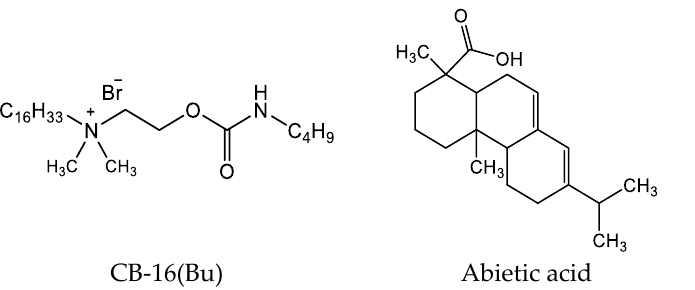
Scheme 1. Structural formulas of compounds in study.